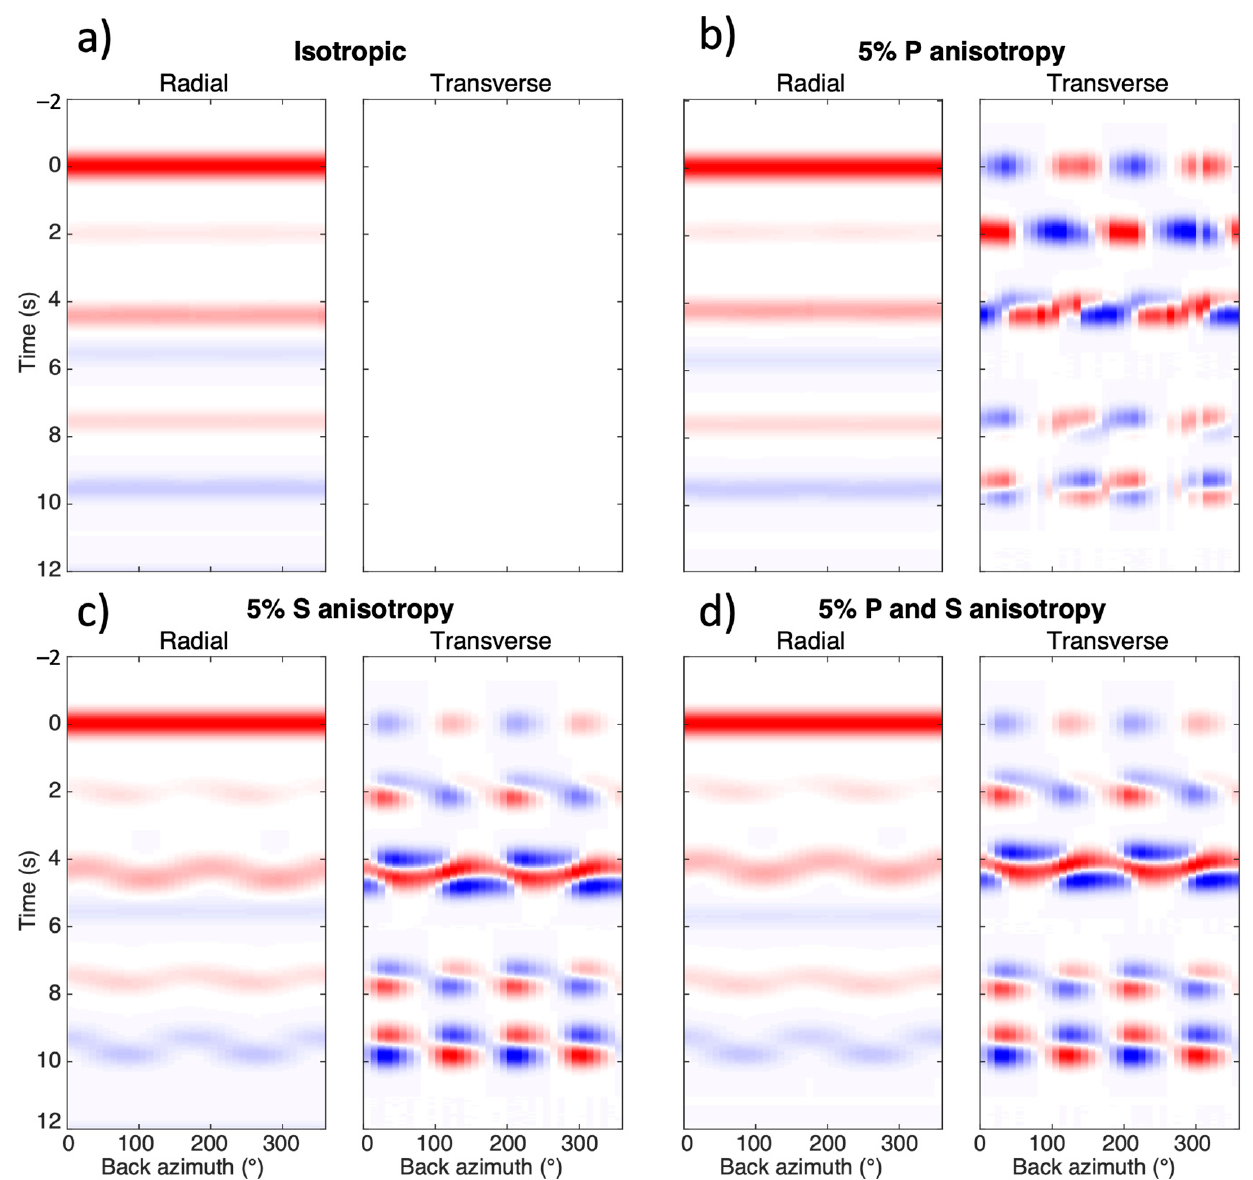
Figure A2. An example of how the results are not highly dependent on the % P anisotropy. ( a ) Isotropic model. ( b ) Only P -wave anisotropy in the model. ( c ) Only S- wave anisotropy in the model. ( d ) Both P- and S- wave anisotropy in the model. The difference between ( c , d ) is minimal. To test whether the low P anisotropy sensitivity holds when the anisotropic axes are not horizontal, we repeated the synthetic test with a 30 ◦ plunge applied to the axes in both layers. Even with this significant plunge, the back-azimuth pattern of polarities remains very similar between the S-only and P+S anisotropies; the pattern is also very similar to what is seen in the horizontal case, though the pattern of transverse polarities of the P arrival becomes two-lobed. For the particular converted arrivals considered in this work, the data are more sensitive to the horizontal component of anisotropy than to its plunge, and more sensitive to the S anisotropy than the P, justifying our focus on the horizontal-axis case with equal P and S